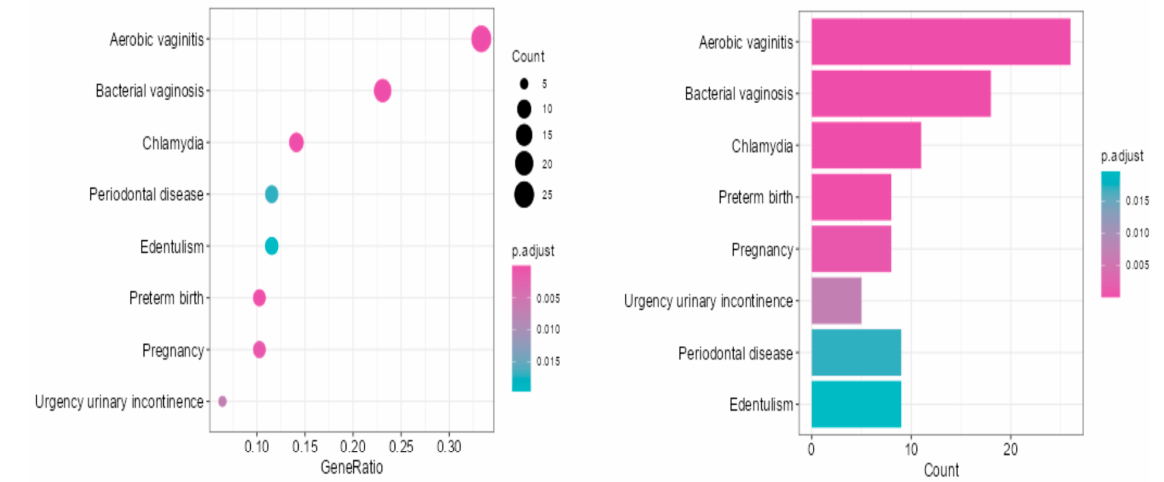
Figure 9 . Comparative disease–microbiome enrichment analysis of vaginal microbiota depicted as line plot and bar plot. A total of 77 significantly different bacterial taxa were reported in the enrichment analysis.